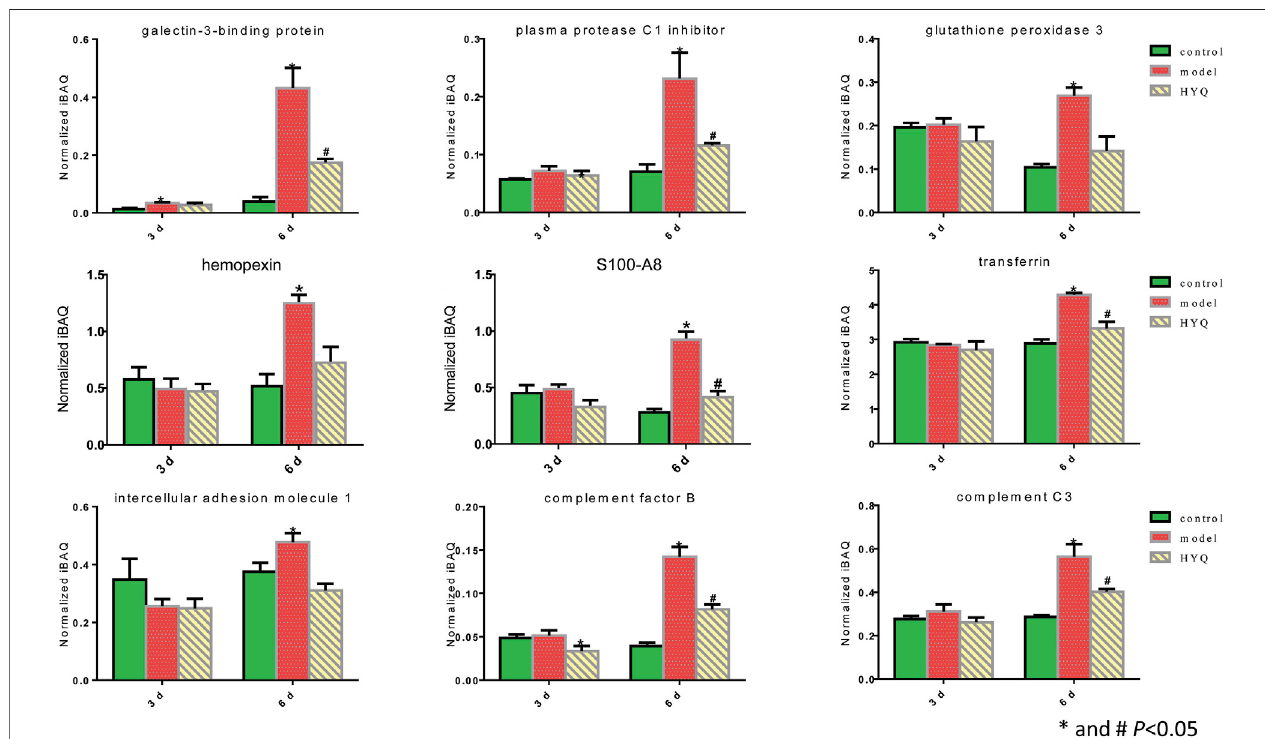
FIGURE 4 | Proteomic quantitative analysis of the candidate signatures regulated by HYQ against viral pneumonia in mouse lung. Three individual samples were analyzed in each group. The normalized iBAQ value of each protein from each individual sample was used for one-way analysis of variance; 3 and 6 days: virus infection